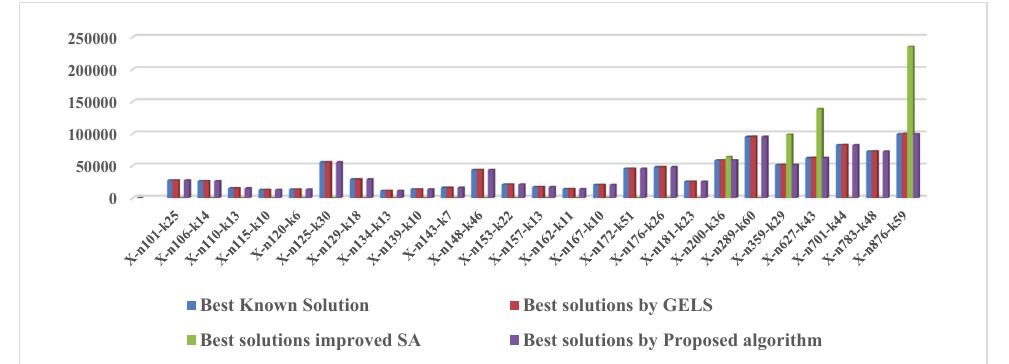
Fig. 3. Graphical representation of Table